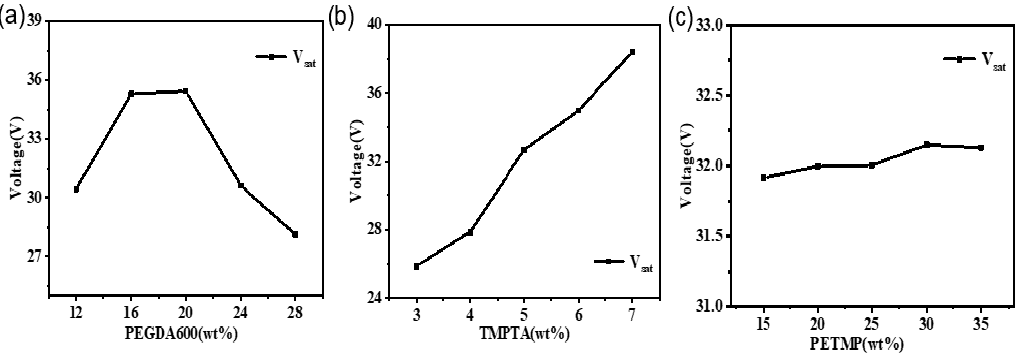
Figure 5. Saturation voltage for samples with different content: ( a ) PEGDA-600; ( b ) TMPTA; ( c ) PETMP. The data were obtained using orthogonal analysis software (Design-Expert 8.0). The target formation in the figure was not affected by the composition of other components, that is, the composition characteristics do not change with the increase of voltage.